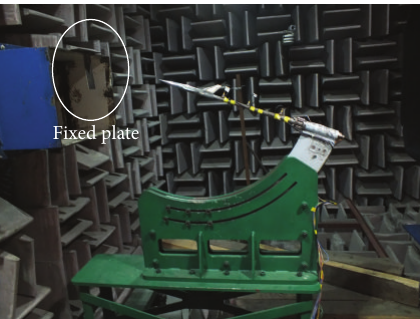
Figure15:Photographofmodelstingsysteminstalledinalowspeed